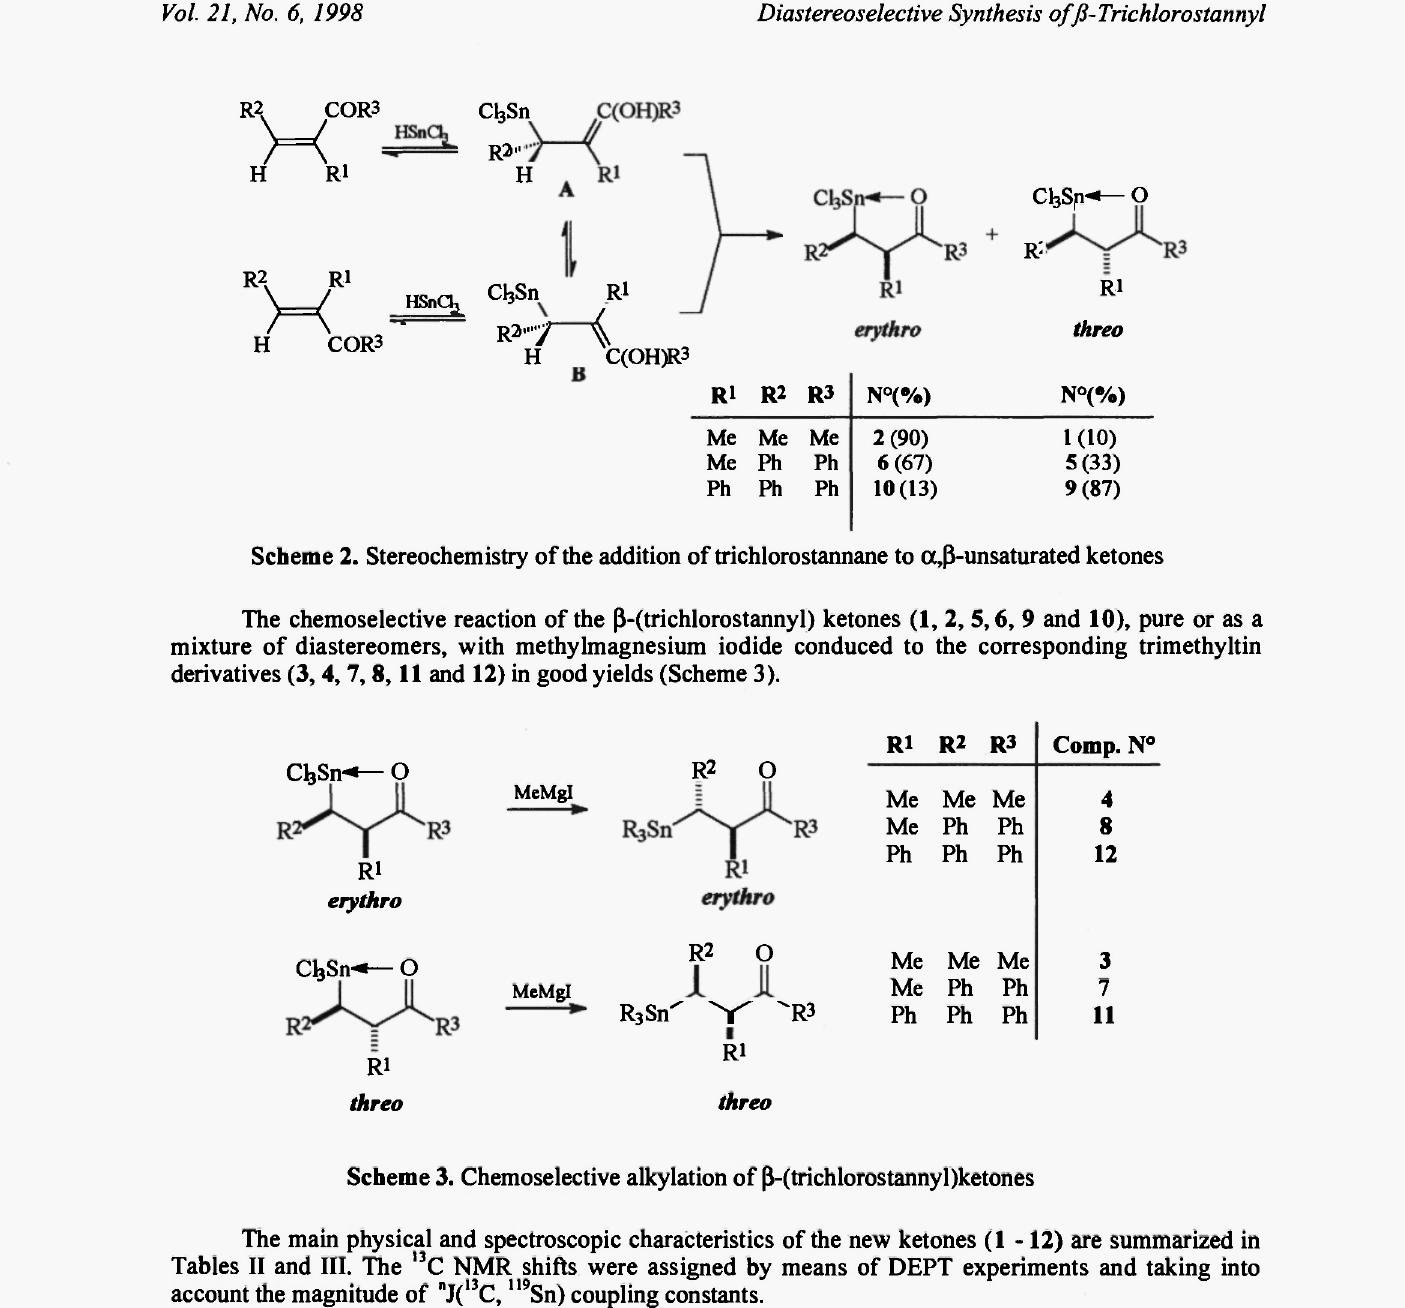
Table II. Physical characteristics and 'H NMR data of compounds 1-12*